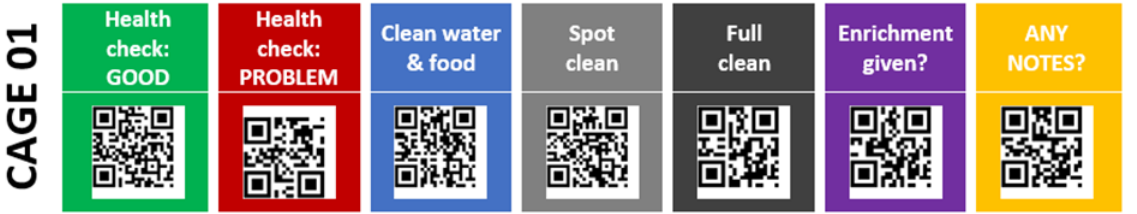
Example Cage QR tag with QR Codes for Six Animal Care Categories and One for Notes